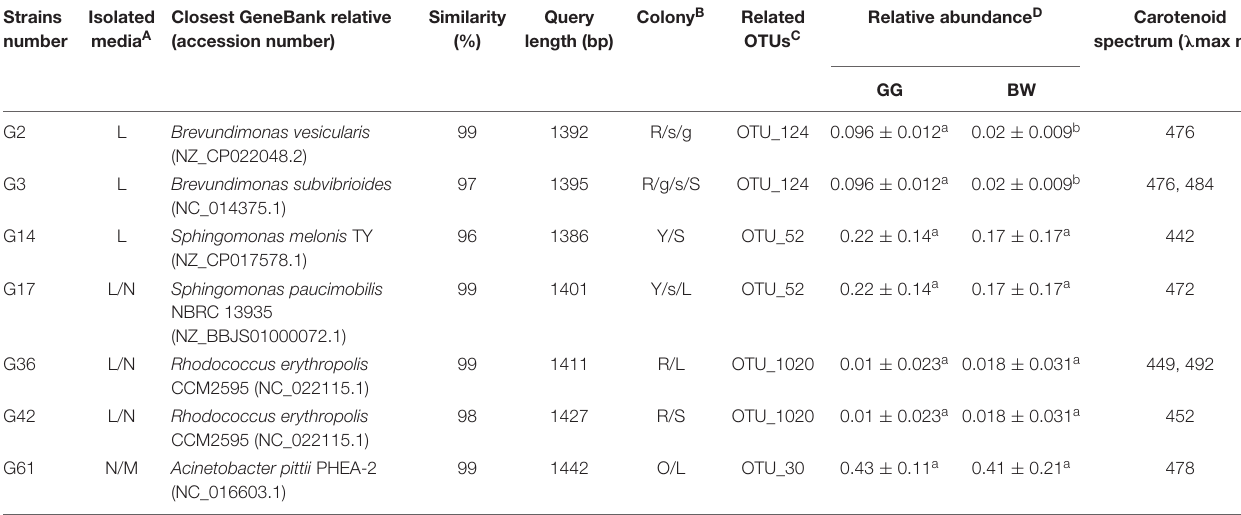
FIGURE 6 | Predicted relative abundance of partial functional genes of PICRUSt-generated functional profile of gut microbiota between golden and brown noble scallops. Significant differences in gene categories related to KEGG pathways at level 3 between two scallop groups (GG and BW). Date are shown as the mean ± SD ∗ P < 0.05. TABLE 2 | Phylogenetic and physiological characteristics of the potential carotenoids-producing